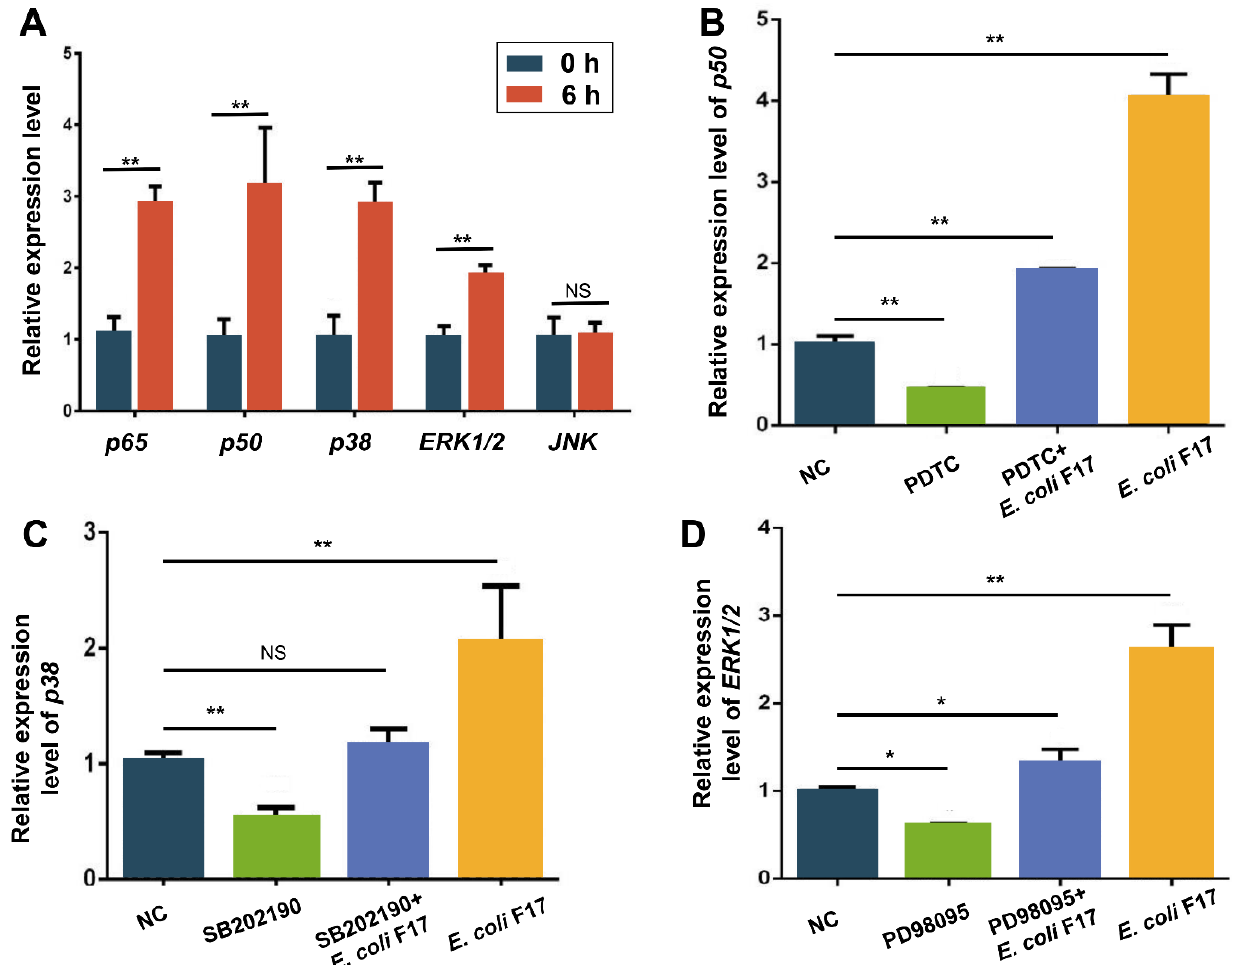
Figure 3. The effect of E. coli F17 stimulation in OIECs on NF- κ B and MAPK pathways. ( A ) p65, p50, p38, ERK1/2 and JNK expression level determined by RT-PCR in OIECs treated with E. coli F17 (10 7 CFU/mL) for 6 h compared with non-treated control. ( B ) p50 expression level determined by RT-PCR in OIECs treated with NF- κ B inhibitor PDTC, PDTC+ E. coli F17 and E. coli F17 compared with non-treated control. ( C ) p38 expression level determined by RT-PCR in OIECs treated with p38 MAPK inhibitor SB202190, SB202190+ E. coli F17 and E. coli F17 compared with non-treated control. ( D ) ERK1/2 expression level determined by RT-PCR in OIECs treated with ERK1/2 MAPK inhibitor PD98095, PD98095+ E. coli F17 and E. coli F17 compared with non-treated control. * p < 0.05, significant difference; ** p < 0.01, extremely significant difference; NS = no difference. Data were shown as mean ± SD, n = 3 biological replicates.